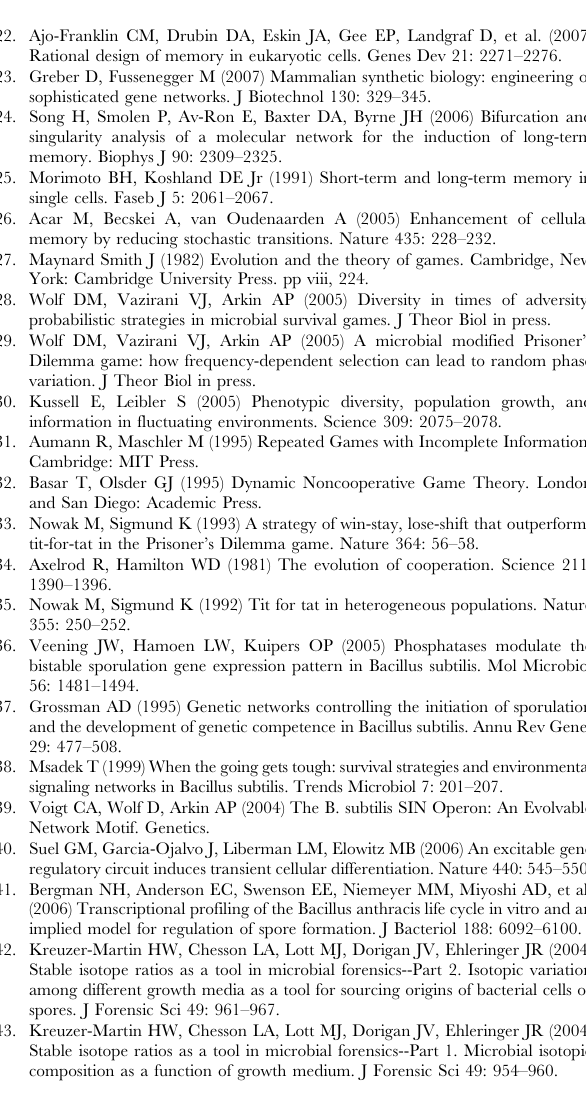
Table S1 Complete set of memory and mutual information calculations.